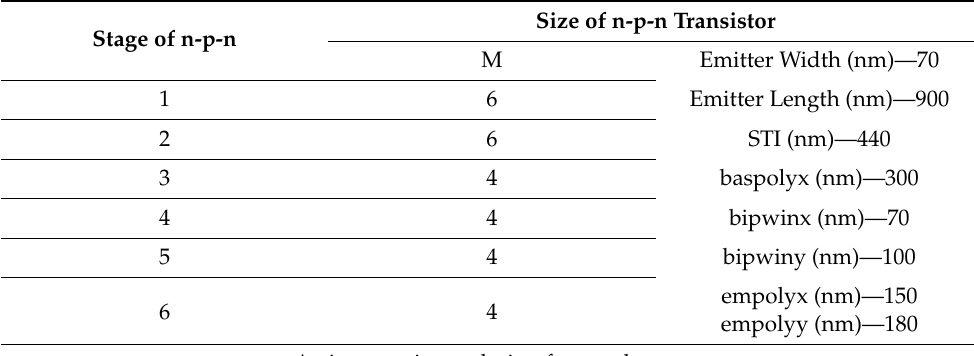
Table 1. The sizes of the HBT devices. Stage of